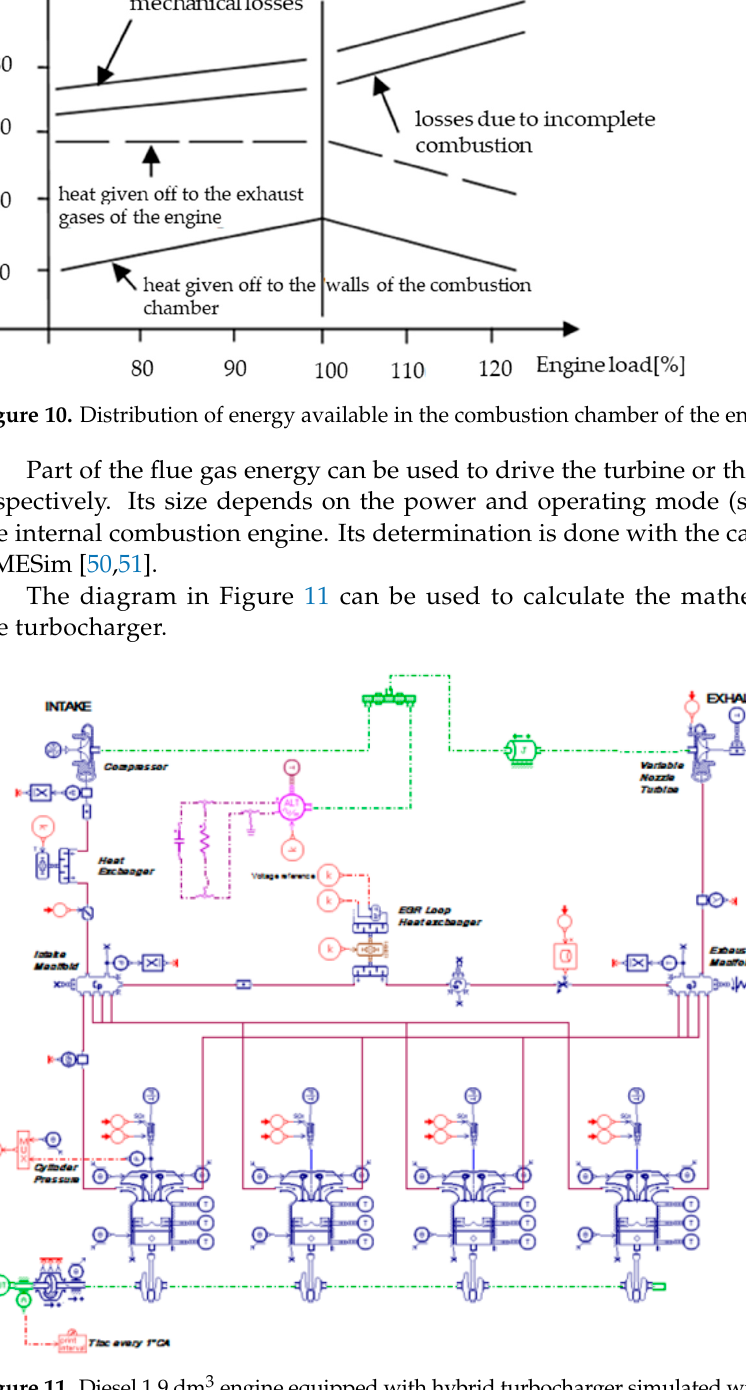
Figure 11. Diesel 1.9 dm 3 engine equipped with hybrid turbocharger simulated with AMESim soft- ware.